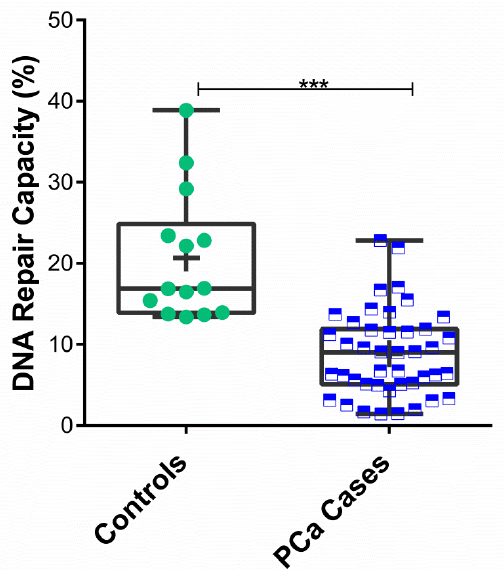
Figure 1. DNA repair capacity levels in prostate cancer cases and controls measured in terms of NER pathway. Sample distributions using the DRC values for PCa cases ( n = 41) and controls ( n = 14). Each box and whiskers represent the median and range values for a study group. Dots and squares represent the individual DRC values for PCa cases (green circles) and controls (blue squares). Mean DRC value for each group is represented with a plus (+) sign. Asterisk (***) represents significant results based on a Mann–Whitney U test, p < 0.001.